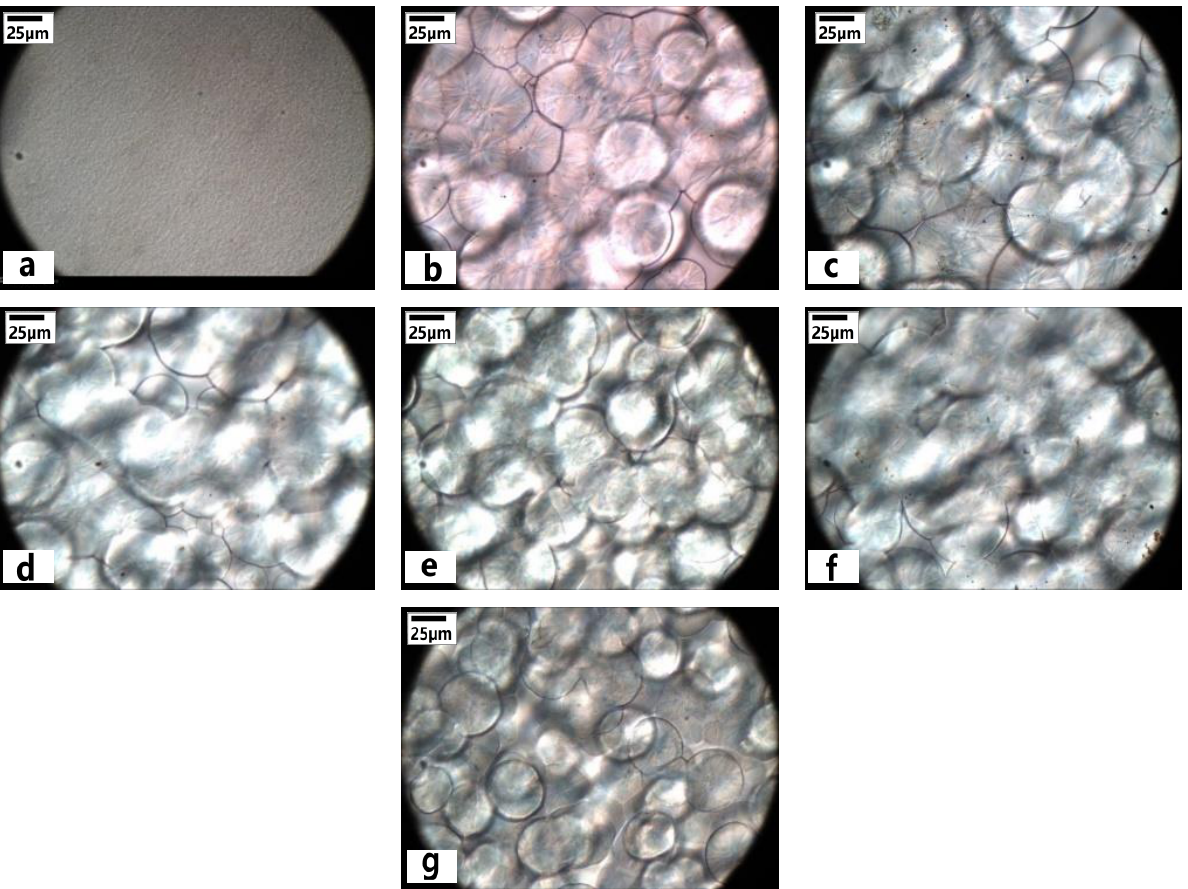
Polymers 2021 , 13 , x FOR PEER REVIEW Figure 1. Morphology of spherulites for pure ( a ) LMPP, ( b ) iPP, ( c ) 5%, ( d ) 10%, ( e ) 15%, ( f ) 20% and ( g ) 25% LMPP blends.